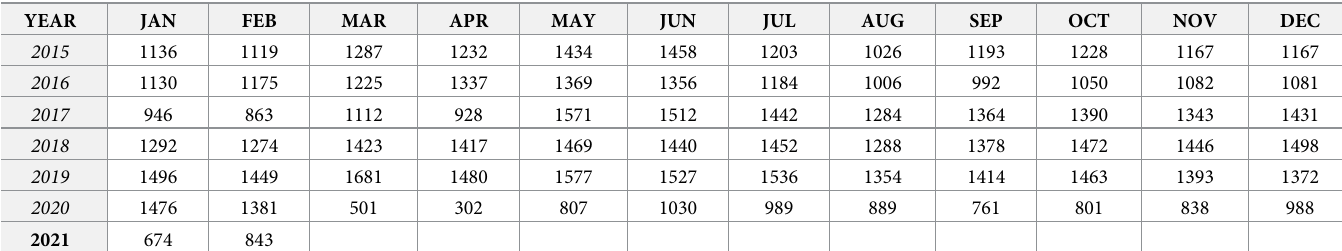
Table 1. Number of visits to the ophthalmological emergency department since 2015.